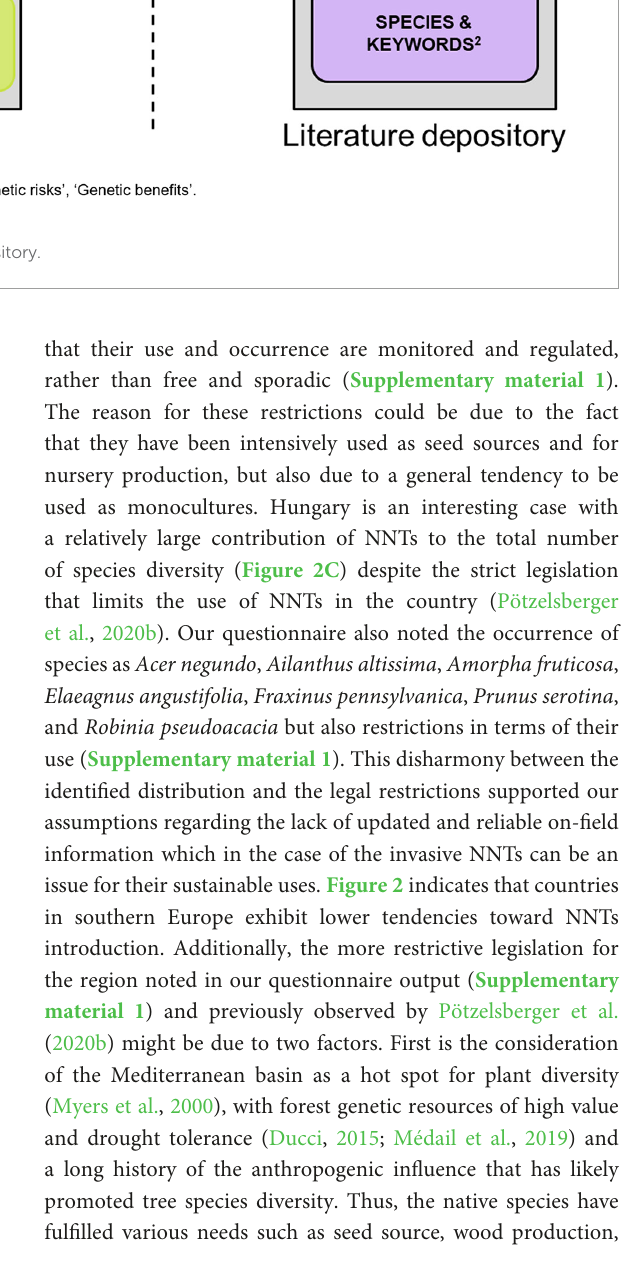
(Pötzelsberger et al., 2020b). For the case of the UK,